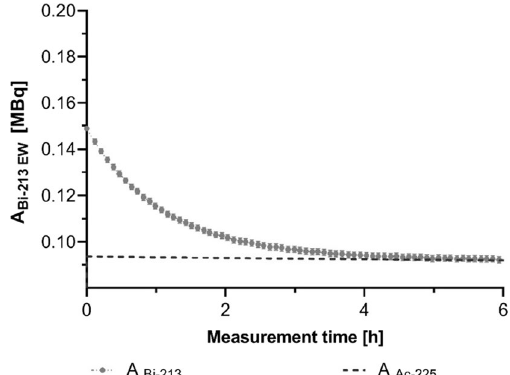
Fig. 5 213 Bi activities of sample 3 (see Table 1) containing 213 Bi in SEq with 225 Ac and an added amount of 213 Bi. GC measurements were performed at different time‑points before and after SEq between 213 Bi and 225 Ac using the EW 213 . Error bars represent the standard deviation provided by the GC software Bi